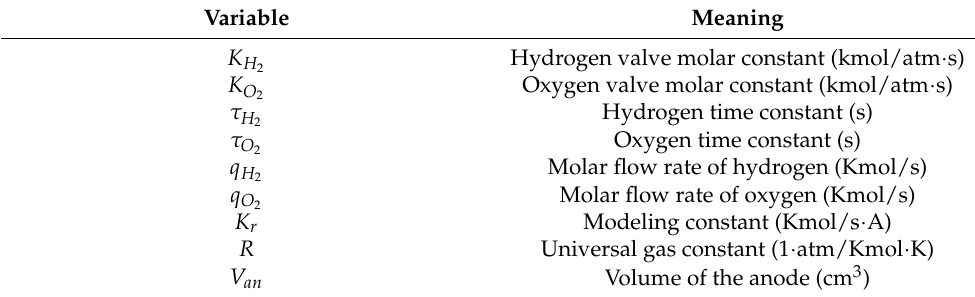
Table 2. PEMFC nomenclature.